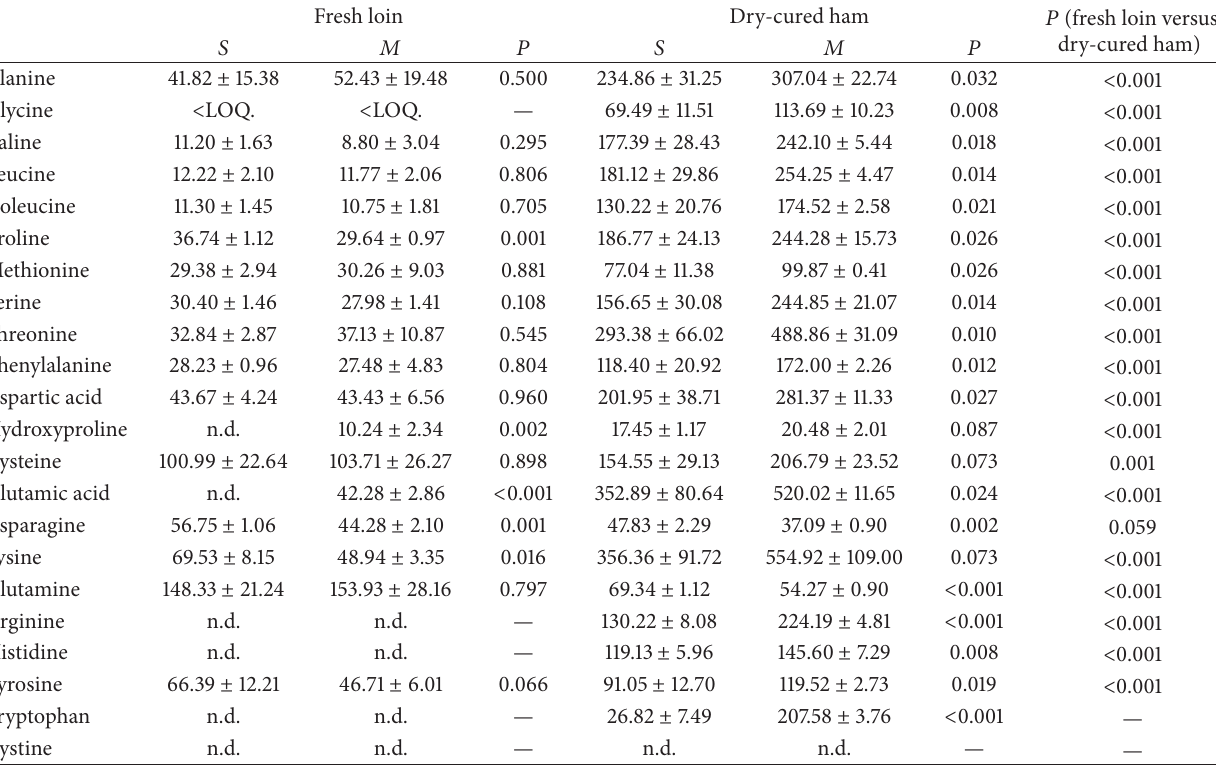
Table 2: Amino acid content (mg per 100 g sample dry matter) extracted from fresh loin and dry-cured ham samples by using two extraction procedures, with stomacher ( 𝑆 ) and mixer mill ( 𝑀